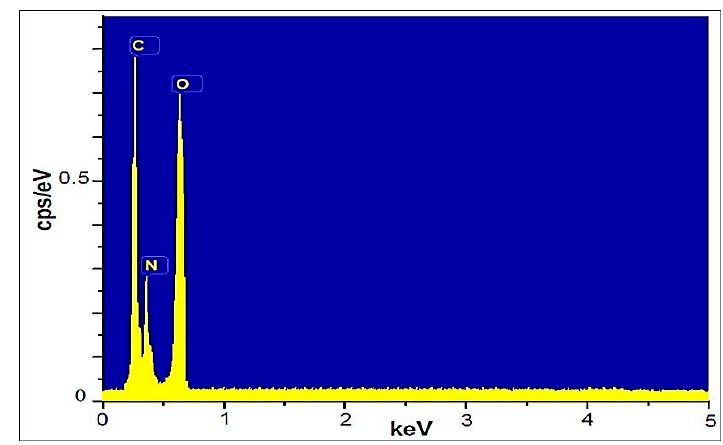
Figure 6. Energy-dispersive X-ray spectroscopy (EDS) spectrum of ETPMP.